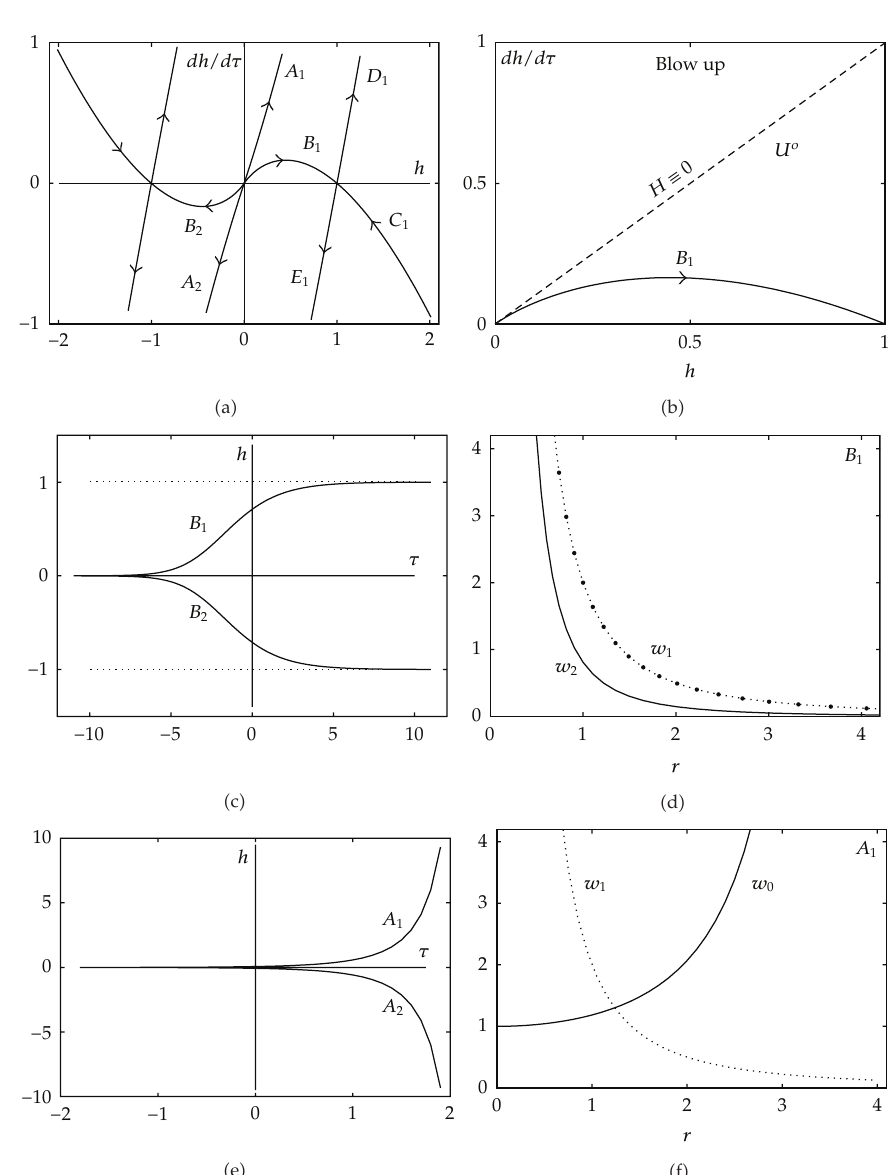
Figure 4: N (cid:5) 3, p (cid:5) 2. Row 1: Solutions on the stable and unstable manifolds associated with (cid:3) h,h (cid:2) (cid:4) ≡ (cid:3) ± 1 , 0 (cid:4) and (cid:3) h,h (cid:2) (cid:4) ≡ (cid:3) 0 , 0 (cid:4) . Rows 2 and 3: h components on A and B 1 ; w 0 (cid:3) r (cid:4) is bounded at r (cid:5) 0, w 1 (cid:3) r (cid:4) (cid:5) 2 r − 2 is the known singular solution; w 2 (cid:3) r (cid:4) is the new, positive singular solution corresponding to heteroclinic orbit B 1